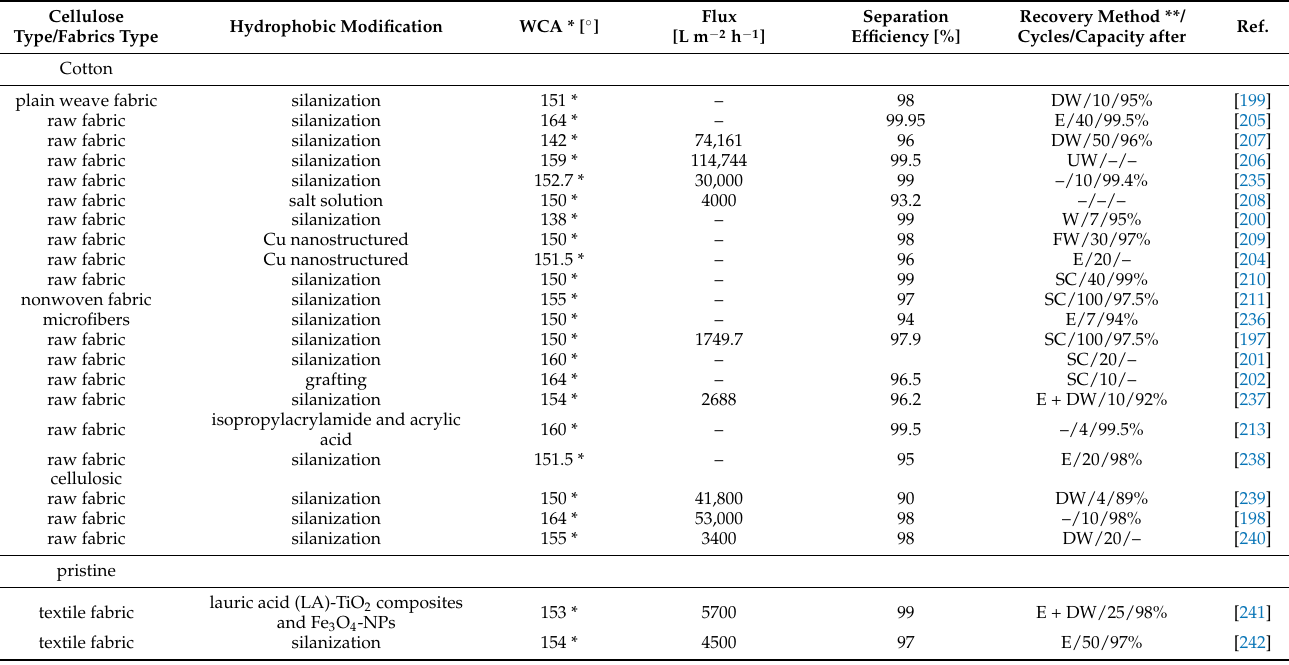
Table 7. Cellulose fabrics for oil removal (values are marked with * if it is the WCA; otherwise the UWCA is reported). Cellulose Type/Fabrics Type Cotton plain weave fabric